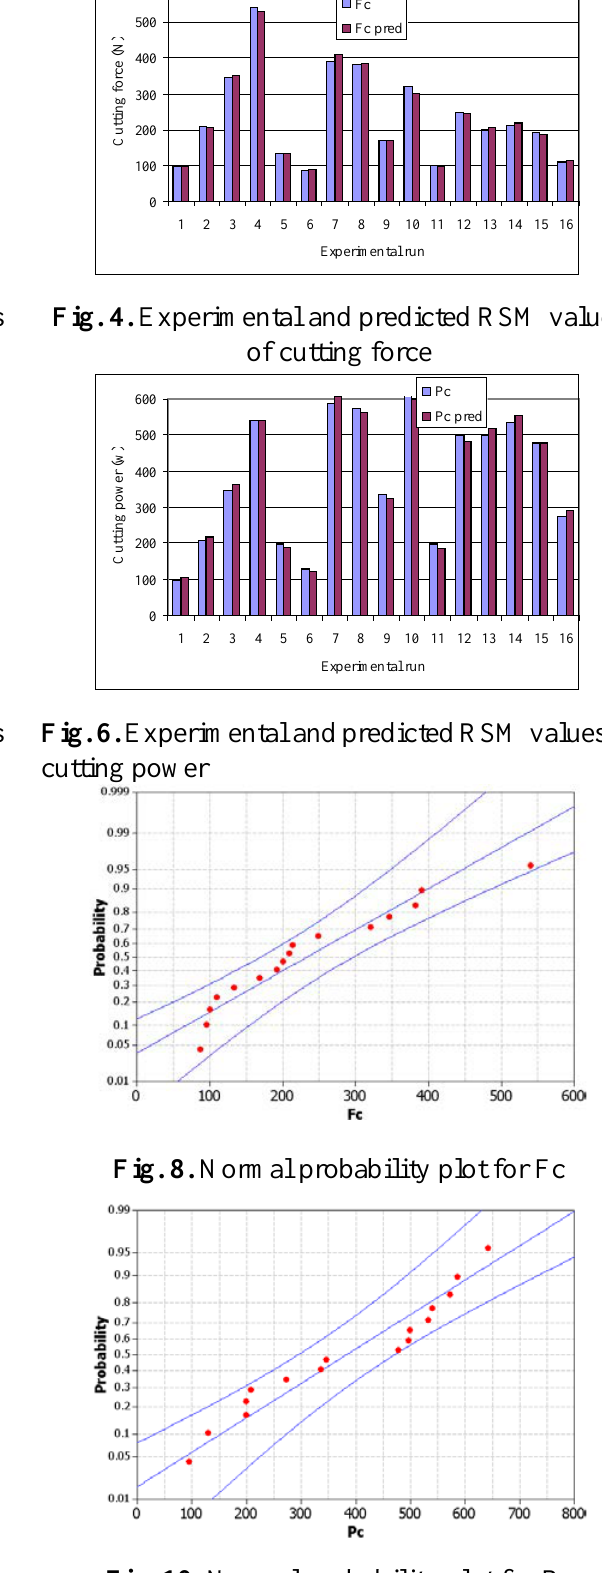
Fig. 9. Normal probability plot for Kc Fig. 10. Normal probability plot for